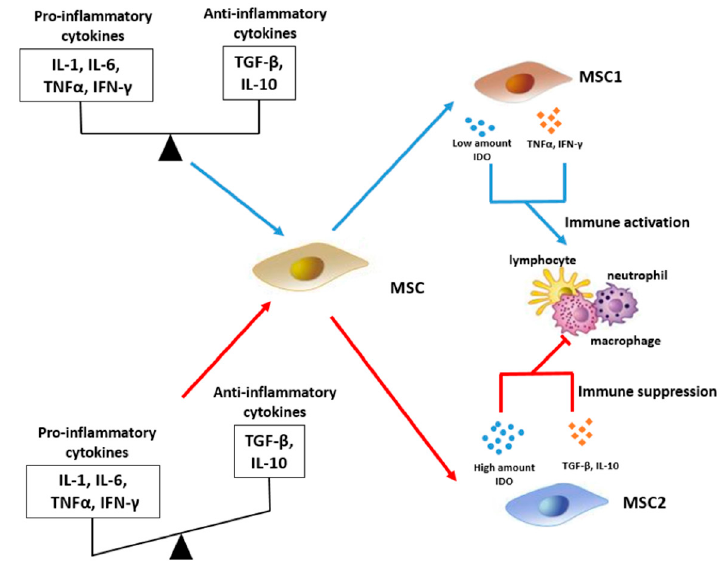
Figure 2. The Opposing Effects of Inflammation on the Immunomodulatory Function of hMSCs. Abbreviations: IDO, indoleamine 2,3-dioxygenase; IL, interleukin; INF, interferon; TGF, tumor growth factor; TNF, tumor necrosis factor.